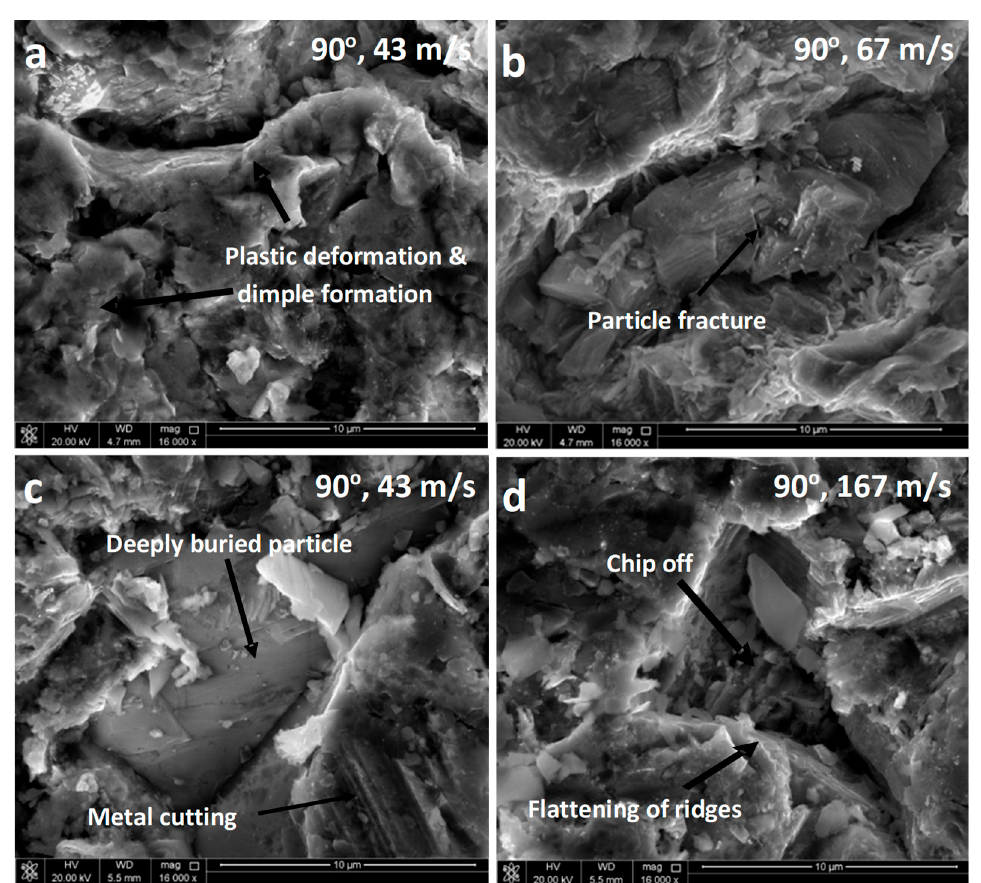
Figure 9. SEM micrograph of steel specimen after erosion at 90° impact angle and different particle speeds of ( a ) 43 m · s − 1 , ( b ) 67 m · s − 1 , ( c ) 92 m · s − 1 , ( d ) 167 m · s − 1 .